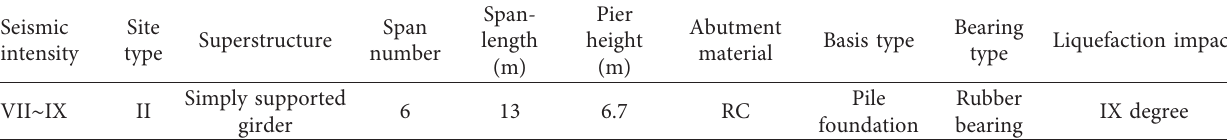
Table 8: Influence factors of seismic damage evaluation.